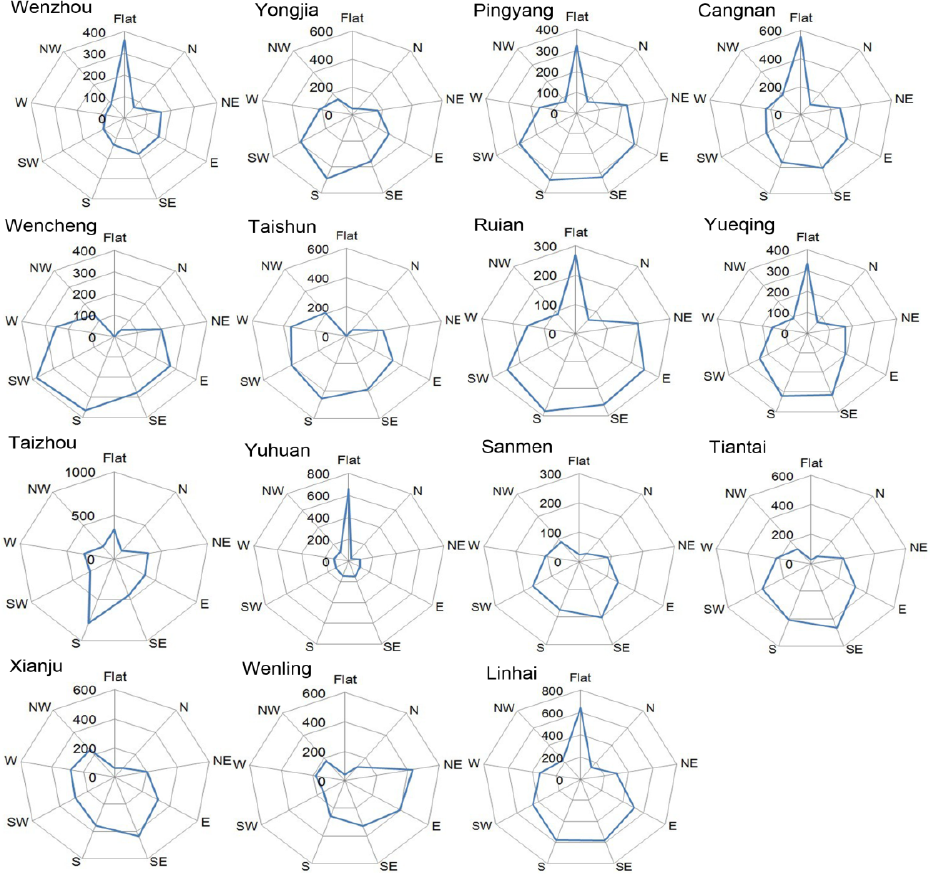
Figure 2. Rose plots of the human settlement aspect in Wen-Tai region, China (N: North; NE: Northeast; E: East; SE: Southeast; S: South; SW: Southwest; W: West; NW: